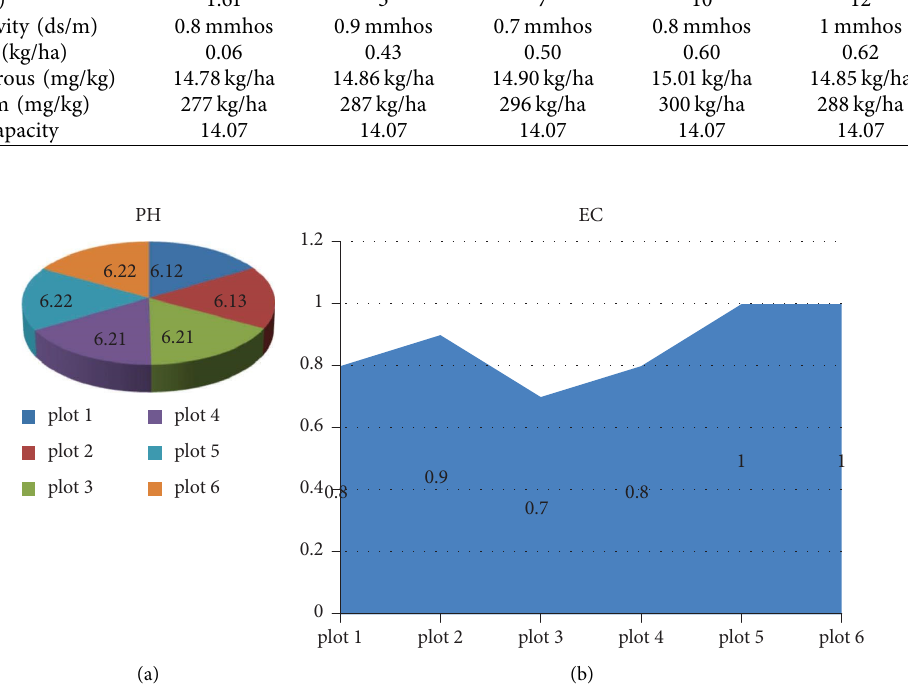
Figure 4: Te diagrams showing the variations of (a) pH and (b)